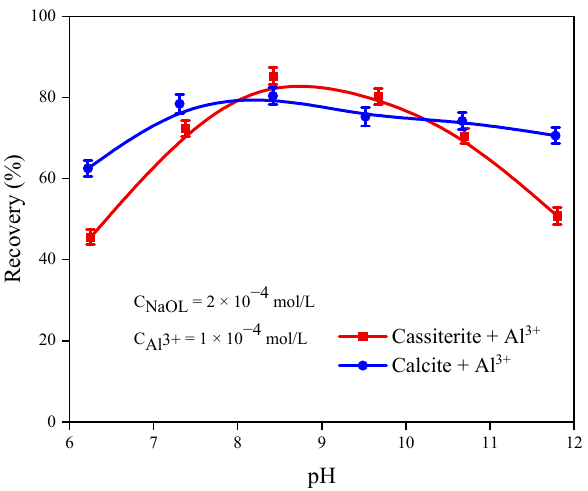
Figure 4. Effect of Al 2 (SO 4 ) 3 on the flotation recovery of cassiterite and calcite. Figure 5 depicts the flotation recoveries of cassiterite and calcite in the presence of the combined depressant AlSS. As can be seen in Figure 5a, the flotation recoveries of cassiterite increase from 56.45% at the pH of 6.19 to the maximum of 82.45% at the pH of 8.50 and then slowly decreased to a minimum of 45.45% at the pH 11.81 with the continuous increase of pH. Similar to the recovery of cassiterite without AlSS, hence no real change in cassiterite recovery. For calcite, the flotation recoveries increased slowly from 3.65% to 16.2% in the whole investigated pH range. At the pH of 8.5, the influence of AlSS concentration on the flotation recoveries is shown in Figure 5b. With the increase of AlSS concentration from 0 mg/L to 100 mg/L, the flotation recoveries of cassiterite decrease slowly from 93.85% to 80.15 mg/L, while the flotation recoveries of calcite decrease sharply from 90.05% to 5.75%. There is no doubt that AlSS has good selectivity for the flotation recovery of cassiterite and